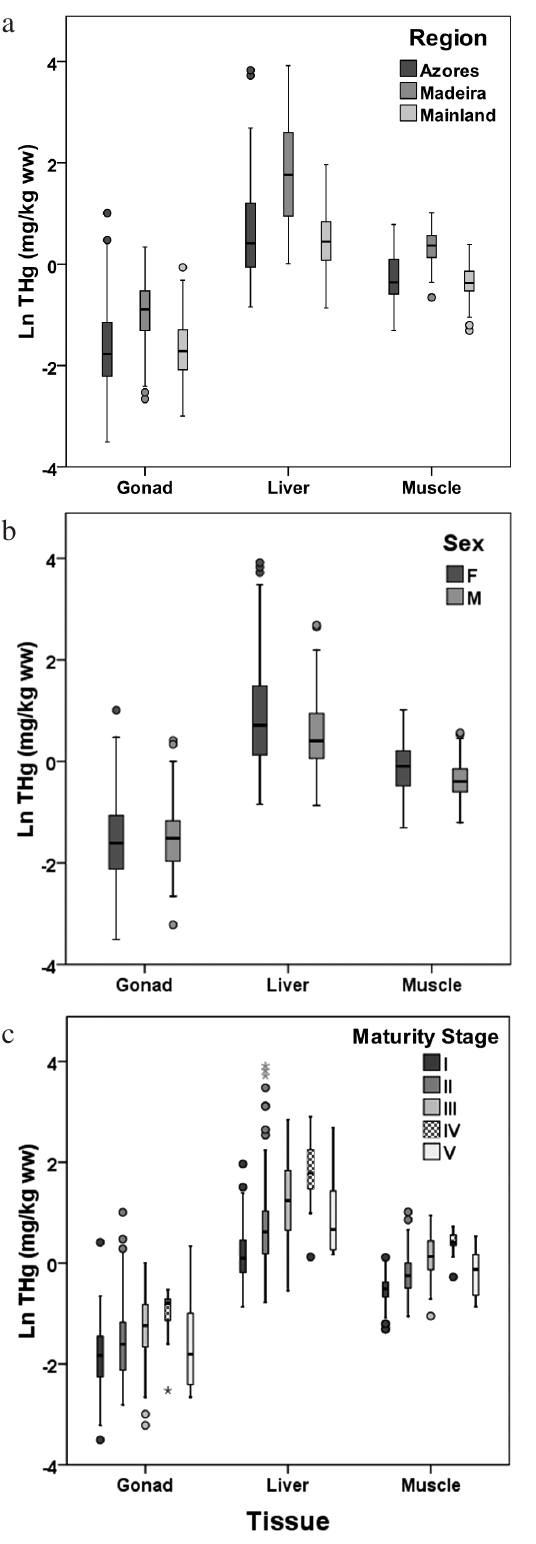
Fig . 3. – box plots of cadmium concentrations by (a) region, (b) sex, and (c) maturity stage. each box plot presents the median, the 1 st and 3 rd quartiles, the maximum and the minimum. the circles correspond to the outliers and the asterisks are the extreme